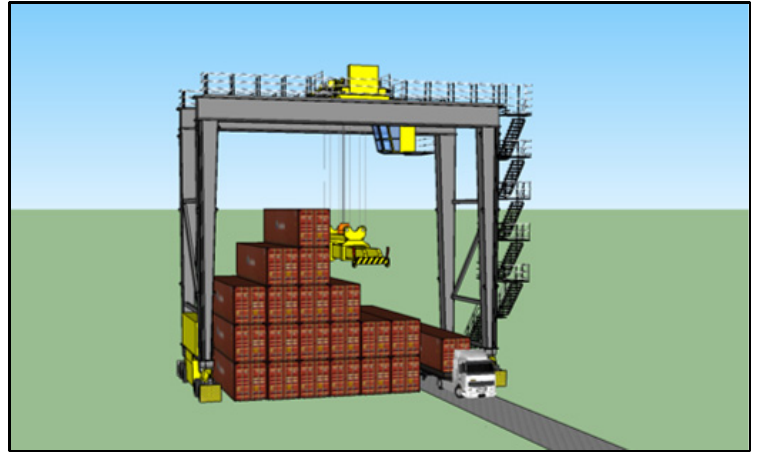
Figure 2. Yard container bay and RTG crane [17].